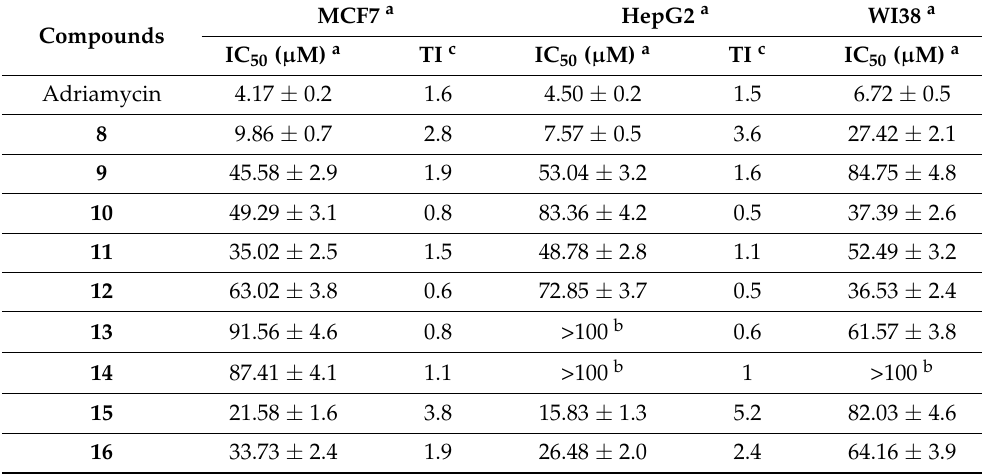
Table 1. The antiproliferative activities of the OSe